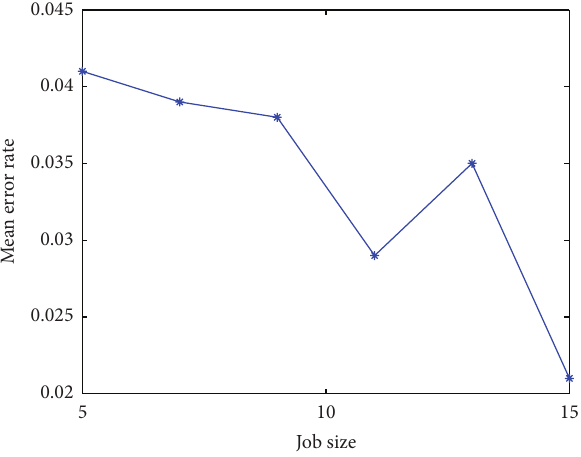
Figure 3: The mean error rate of the HA for 1|𝑝 𝑖𝑟 , mrm |𝐶 max